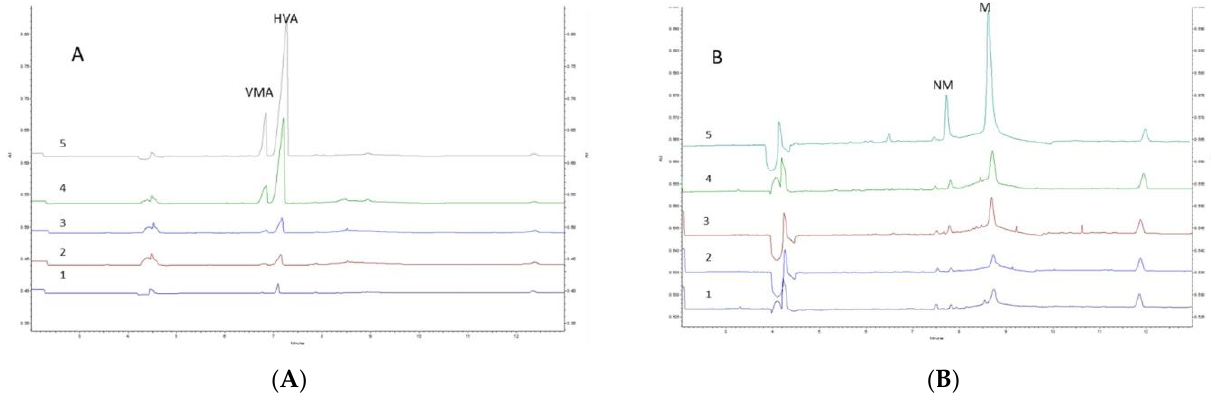
Figure 2. Electropherograms of artificial urine samples spiked with analytes obtained after SPE- HLB at a sample pH 5.5 ( A ) and 9.0 ( B ). Concentration of analytes within the method’s linearity: 0.25 µg/mL (1), 0.5 µg/mL (2), 0.75 µg/mL (3), 5 µg/mL (4), and 10 µg/mL (5). Separation conditions: applied voltage—25 kV; capillary—60.2 cm and 75 µ m i.d.; λ = 200 nm; injection time—15 s. The BGE consisted of 5 mM sodium tetraborate decahydrate, 50 mM SDS, 15% ( v / v ) MeOH, 150 mM boric acid, and 1 mM of [HMIM + Cl − ].